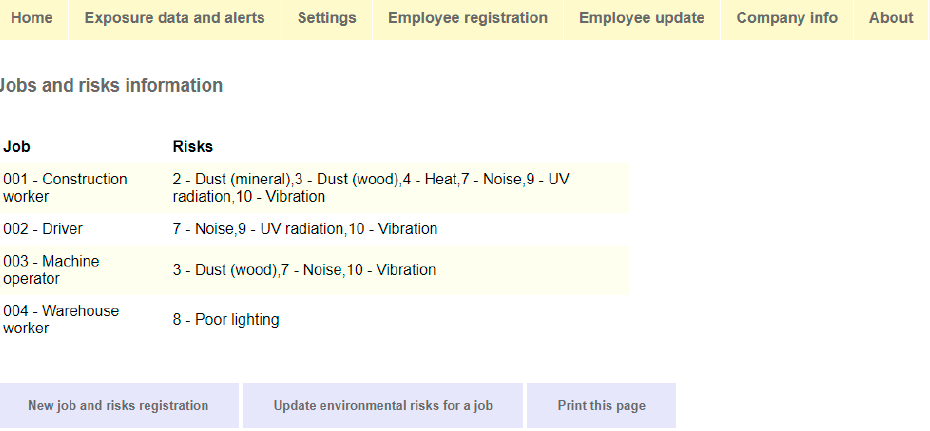
Figure 4. Example of job history with health details. Risks for the same job cannot be recorded more than once. If an employer wants to update risks, he or she needs to click on the “Update environmental risks for a job” button. Otherwise, the proper page used to update risks is shown and a warning is displayed, as well as advice to update the risks if sure. With jobs and risks registered, it is possible to register employees and associate them with monitoring devices. For this purpose, the user must select a device from a list and enter one unique four-digit employee ID number. If the user enters a device ID or an employee ID that is already registered, an error message is shown. Another device and/or employee ID must be chosen in this case. To unlock a device ID that is already in use, it is necessary to disassociate the device from its respective employee. This can be achieved by updating the employee’s status: the employee’s resig- nation or retirement can be informed. In addition, the employee’s position can be changed, and if necessary, a new device can be associated with it, unlocking the previous one. After associating the employee with the monitoring device, it is necessary to provide infor- mation about the employee’s health history. If he or she has any diseases, they must be selected from a pre-defined list. The employee might have the skills to perform more than one professional activity in the company. In this case, the other job possibilities must be informed in this stage by selecting the jobs (if any) from a list, and this information can be updated as needed. Figure 4 shows the history of an employee at the company. In this example, the worker performed a single activity (in the warehouse) since he joined the company. If desired and/or needed, he can also act as a driver. His health conditions are also shown.